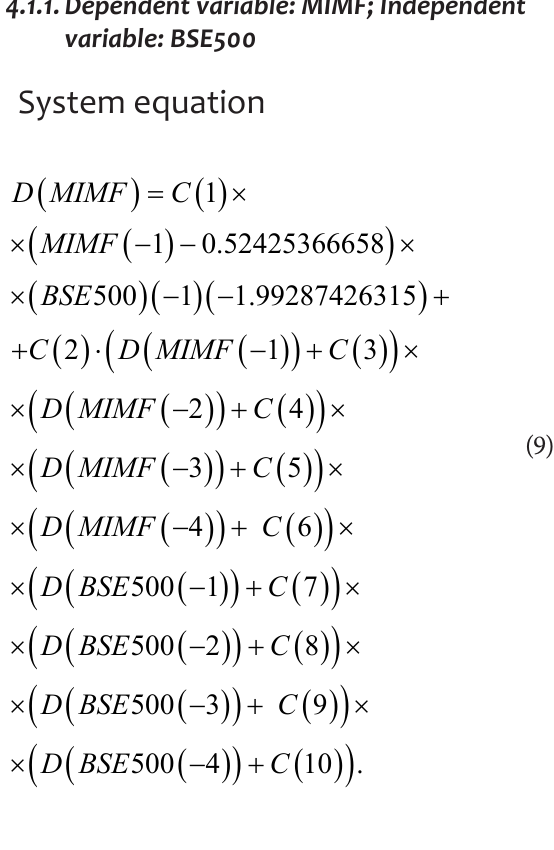
Table 6. Johansen co-integration test outcome – MAMF and ASX300